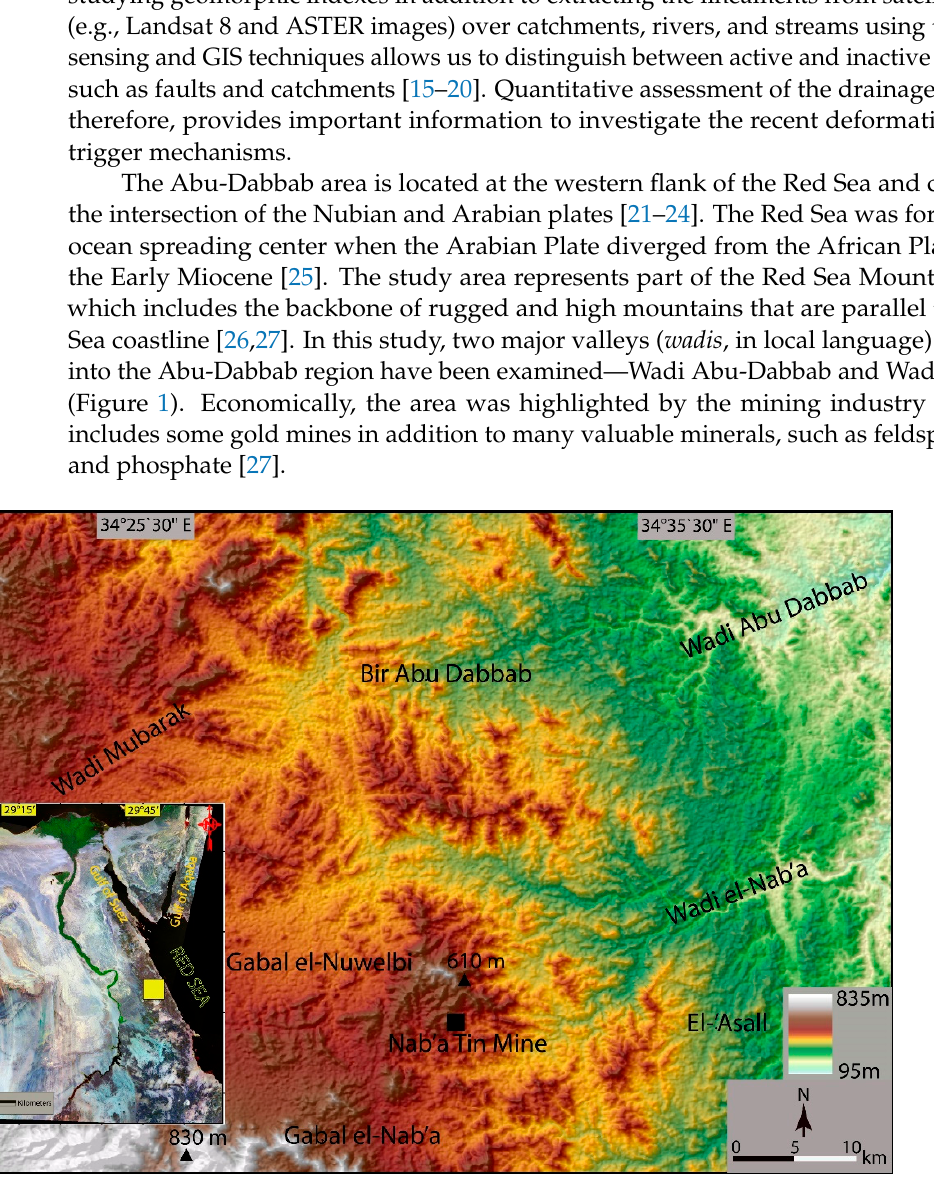
Figure 1. Shaded relief image illustrates the main features of the study area. The yellow square shows the location of the study area. Digital elevation model (DEM) data of the study area was downloaded from the USGS EarthExplorer (https://earthexplorer.usgs.gov/ accessed on 10 November 2021).